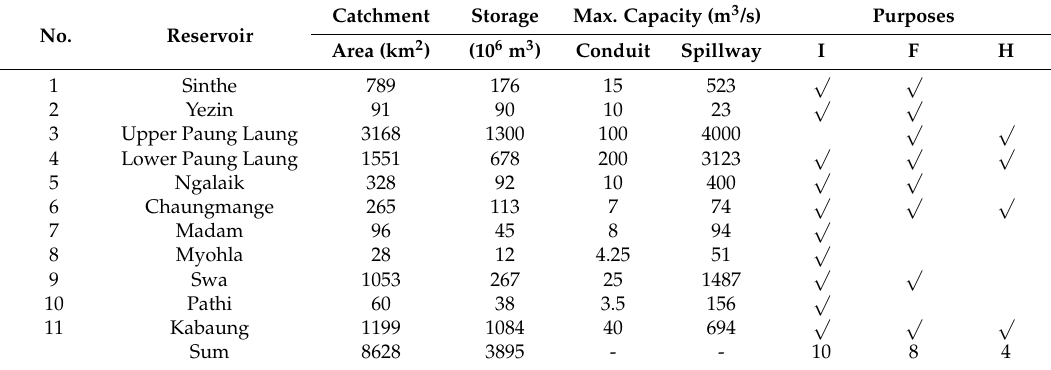
Table 1. Reservoirs considered in this study. (purposes of reservoirs: I = Irrigation, F = Flood control, H = Hydropower).